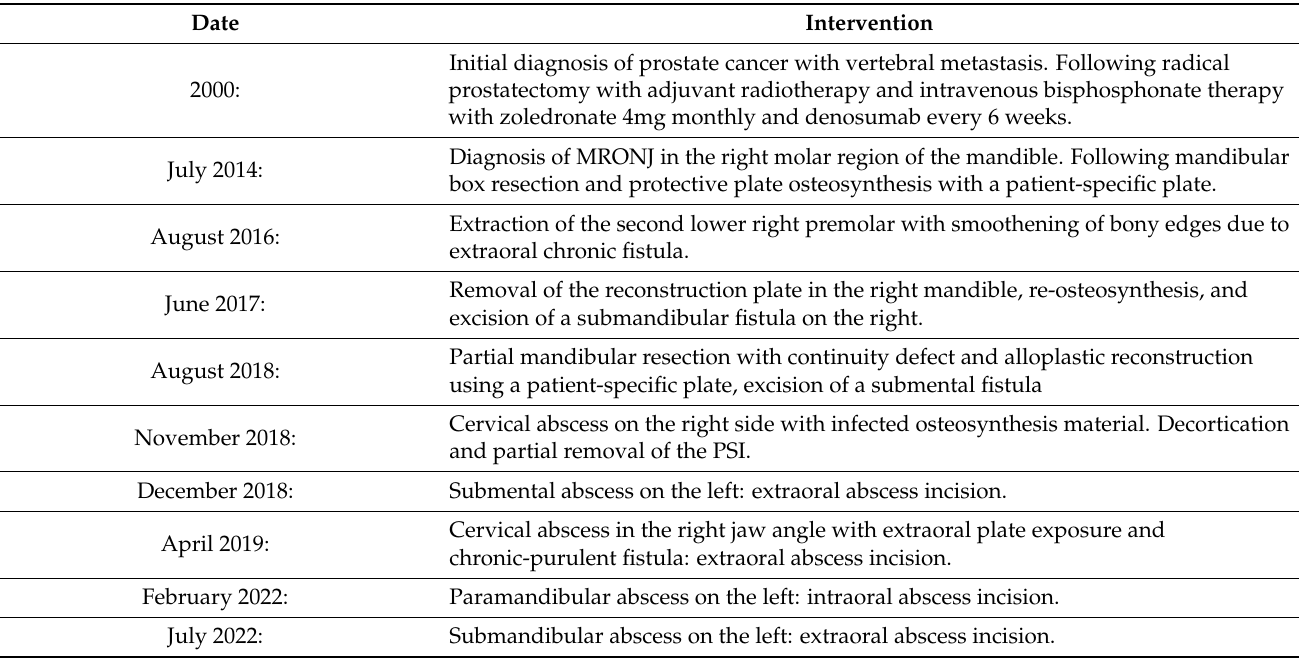
Table 1. Timeline of patient case no. 1, PSI = patient-specific implant, CAD/CAM = Computer-Aided Design and